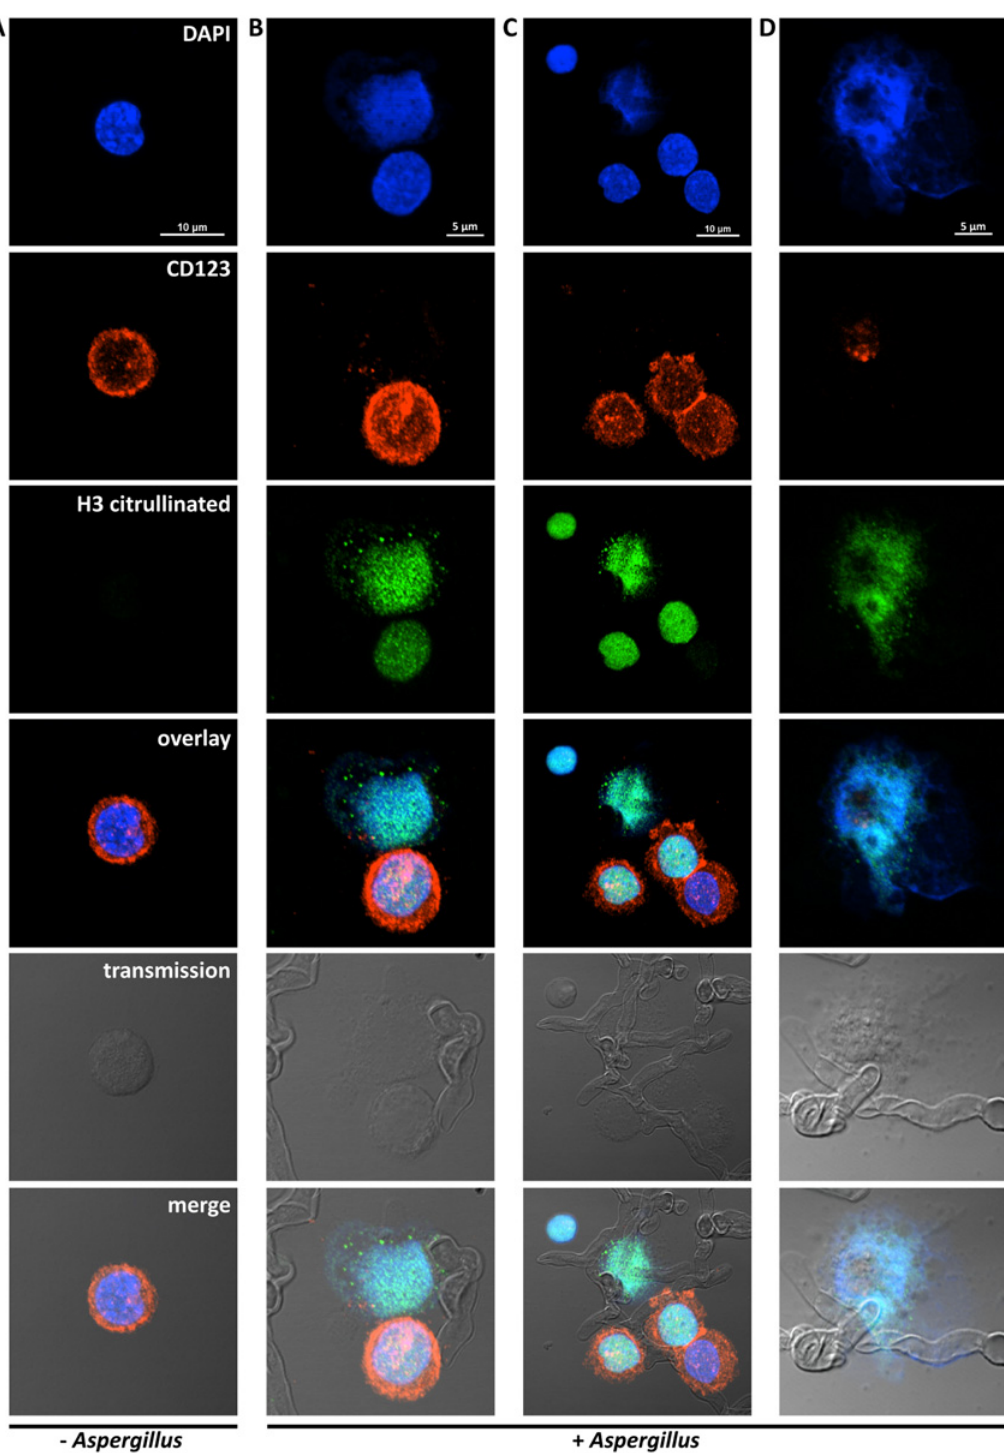
Fig 4. Detection of pDC extracellular traps (pETs) by immunofluorescence. Human pDCs (2 × 10 5 /well) were left unstimulated (Unstim) or stimulated for 4 hr with A. fumigatus hyphae (2 × 10 5 ). pDCs associated with A. fumigatus hyphae showed evidence of ETosis. pETs were visualized by indirect immunofluorescence using primary antibodies against citrullinated histone H3 and the pDC marker CD123. Alexa Fluor 488- and 568-conjugated secondary antibodies were used for visualization of citrullinated histone H3 (green channel) and CD123 (red channel), respectively. DNA was stained with DAPI. Images were captured with a confocal microscope and a 60x oil immersion objective. Wavelengths of 405 nm (diode), 488 nm (Argon), and 543 nm (HeNe)